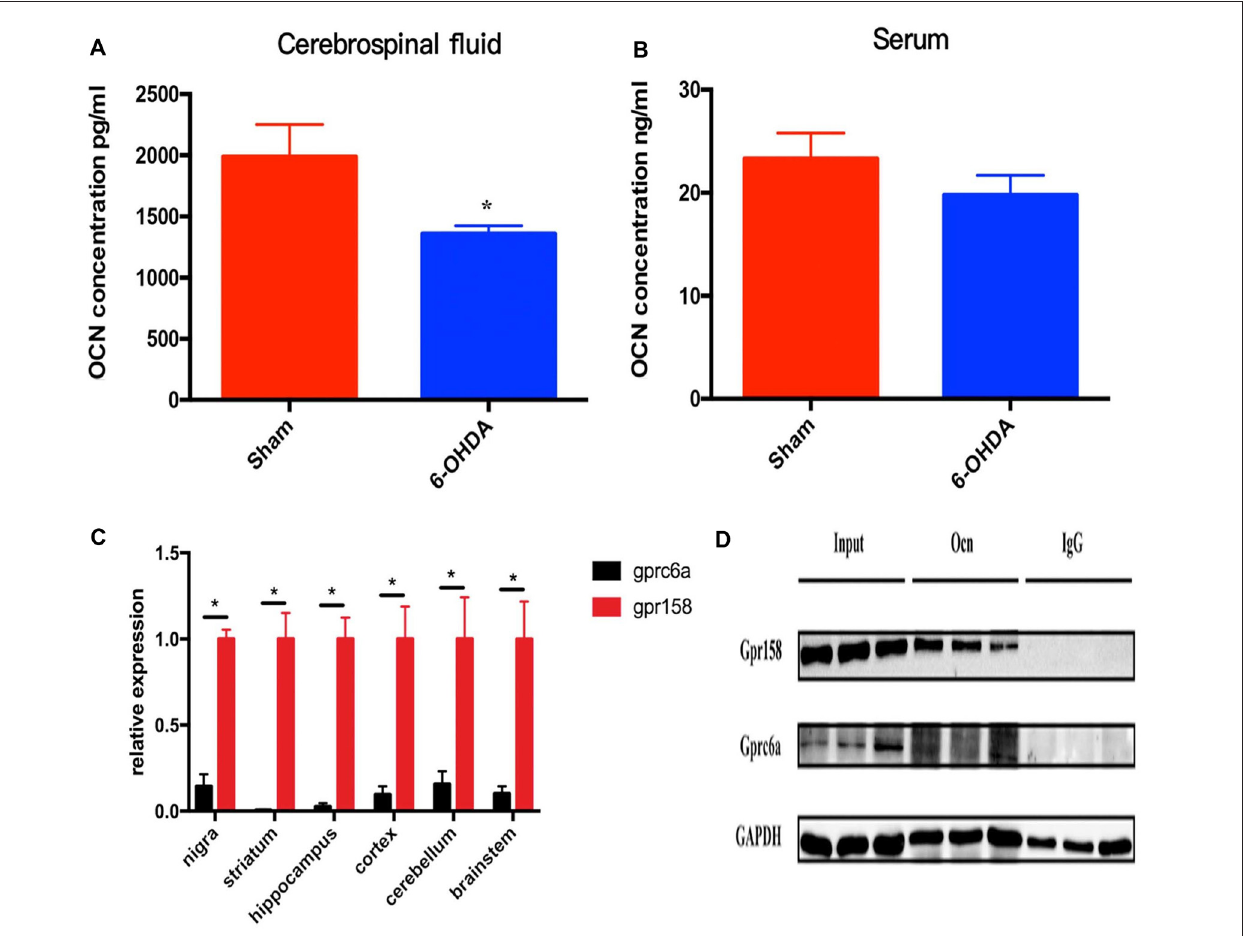
FIGURE 1 | The levels of osteocalcin (OCN) in the serum or cerebrospinal fluid (CSF) of control and 6-hydroxydopamine (6-OHDA)-induced Parkinson’s disease (PD) rat models. The CSF OCN levels in PD rats dramatically decreased compared to control rats ( A , n = 17). No difference in the serum OCN levels was found between control and PD rats ( B , n = 19). Expression of GPR158 and GPRC6A in various brain-derived tissues of 8-week-old rats ( C , n = 3). Coimmunoprecipitation of 8-week-old mice striata and proteins were then subjected to western blot analysis using anti-Gpr158 and anti-GPRC6a antibodies ( D , n = 3). Values were obtained from three independent experiments and results are given as the mean ± SEM. ∗ P <